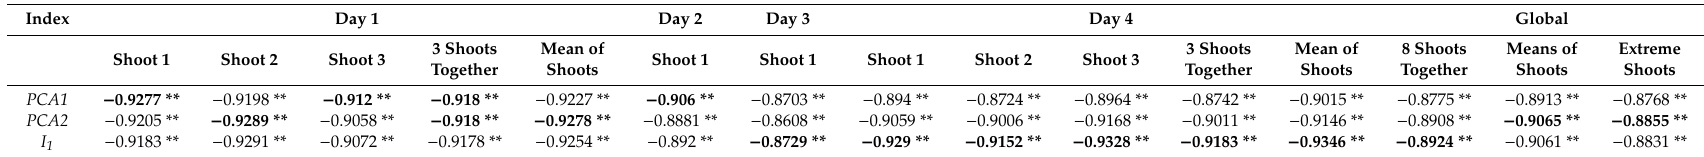
Table 5. Correlation coe ffi cients for new indices obtained by PCA process. Results are given for each individual shoot, for daily values on days #1 and #4 (taking into account the three shoots altogether or the mean values of the three shoots) and for global datasets. The latter include data from all the days using the eight shoots, data from all the days using mean values for days #1 and #4 and mean values between extreme shoots (the darkest shoot from day #1 and the brightest shoot from day #4). The highest R-values are highlighted in bold typeface. Significance level: ** ( p <